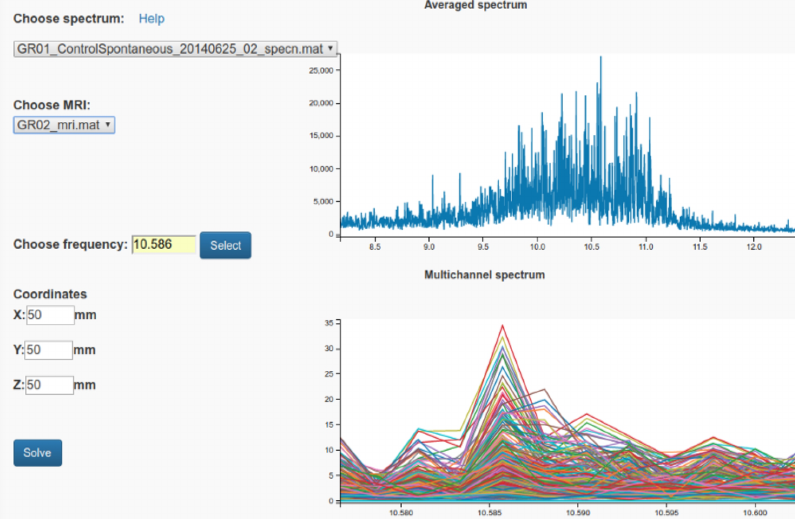
Figure 1. MathBrain architecture